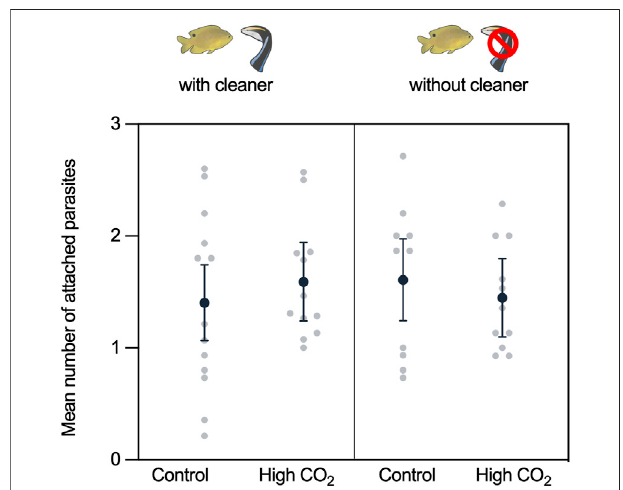
FIGURE2| Meannumber ofattached gnathiidsduring the experimental parasite infection. Back-transformed predicted means ±95% con fi dence intervals (C.I.) from the model and raw data values are